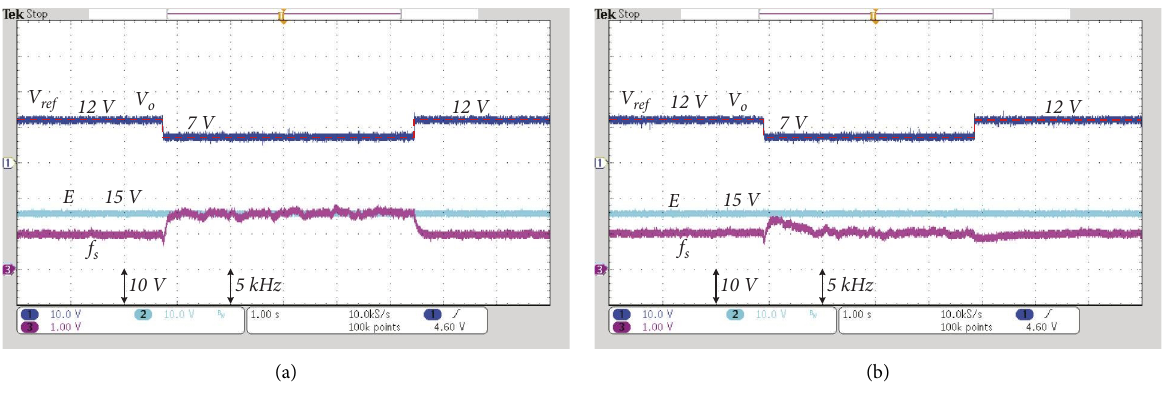
Figure 14: Proposed control: (a) without FCL; (b) with FCL.